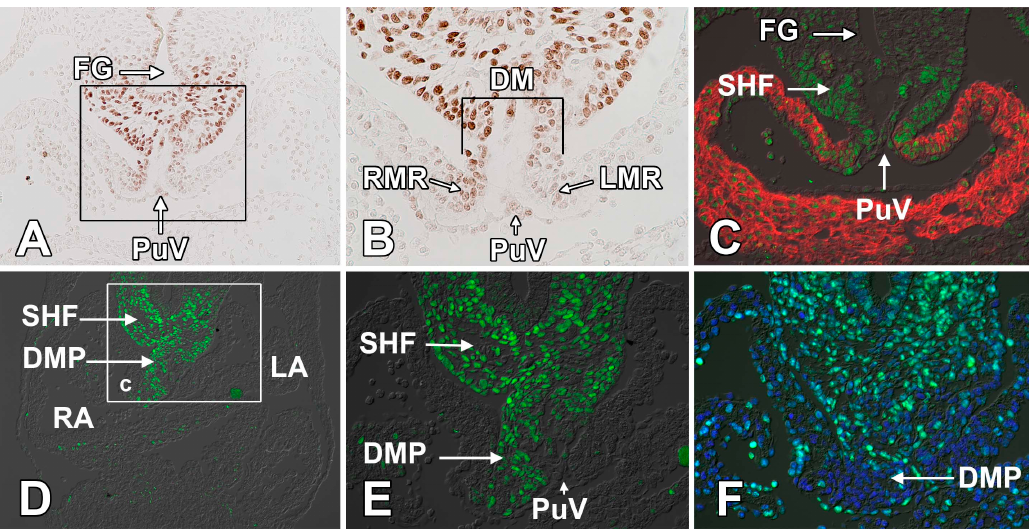
Figure 3. The Dorsal Mesocardium and the development of the Dorsal Mesenchymal Protrusion. ( A , B ) show a section of the venous pole of a mouse heart at 9.5ED stained for the expression of Isl1 (( B ) is an enlargement of boxed area in ( A )). Isl1 expression (brown nuclei) can be seen in the second heart field located between the dorsal mesocardium and the foregut. ( C ) is a section in the same area of a different heart at the same stage labeled for the expression of the myocardial marker Myosin Heavy Chain (red) and the expression of pSMAD1,5,8 (green) showing active BMP signaling.